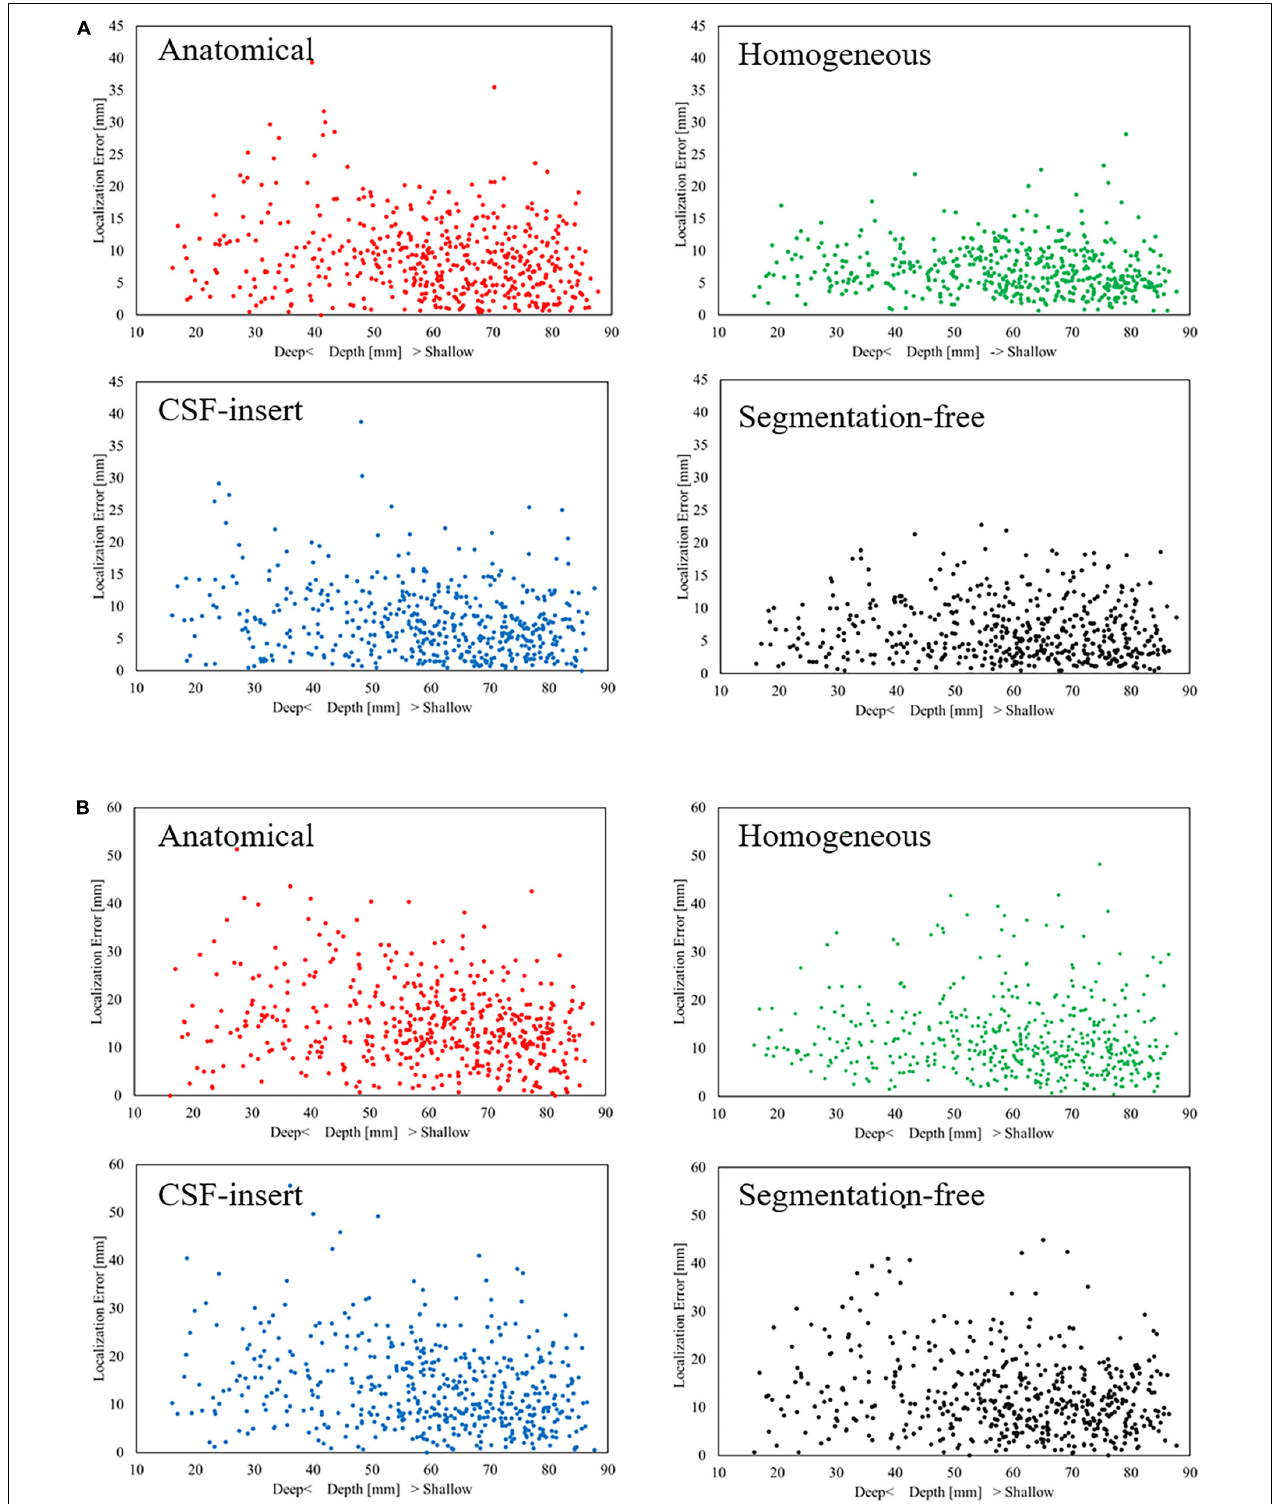
FIGURE 5 | Relationship between depth and localization error with (A) International 10–10 system and (B) International 10–20 system in different head models for SNR = 5 dB. Each dot represents the localization error at 1 of the 500 selected test sources.